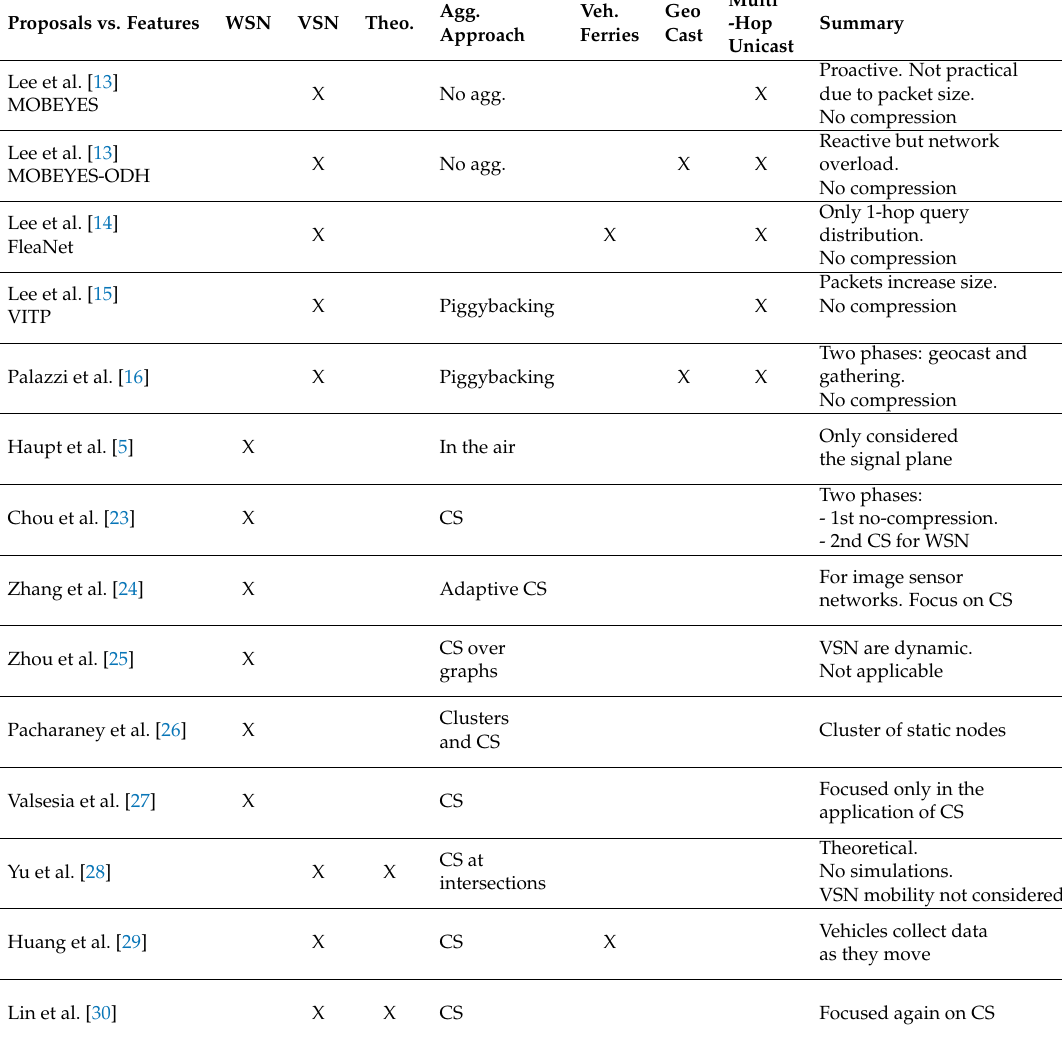
Table 1. Summary of proposed compressed sensing (CS)-based solutions applied for data gathering in the WSN or Vehicular Sensor Network (VSN) domain. Legend: Theo. means that only a theoretical approach has been considered; Agg. approach means Aggregation or combination approach followed to include new information; Geocast means that a geocast method has been considered for the distribution of a message in a region of interest (RoI); Multi-hop unicast means that the proposed method considers a multi-hop mechanism to transmit the information towards a